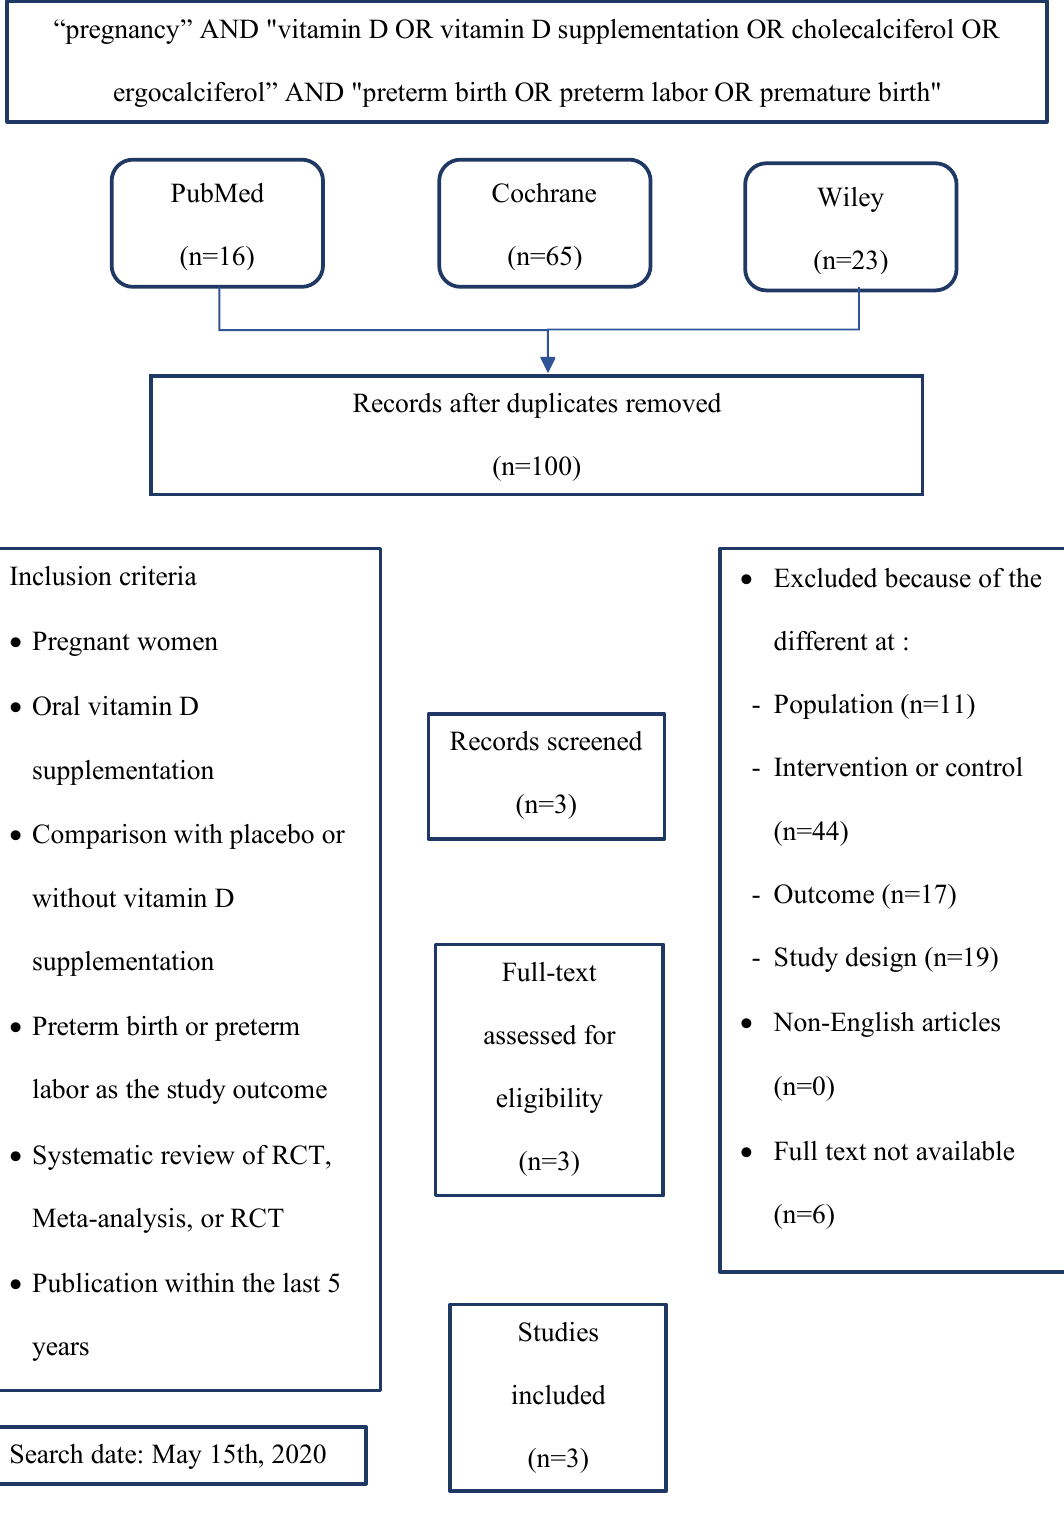
Figure 1. PRISMA flow